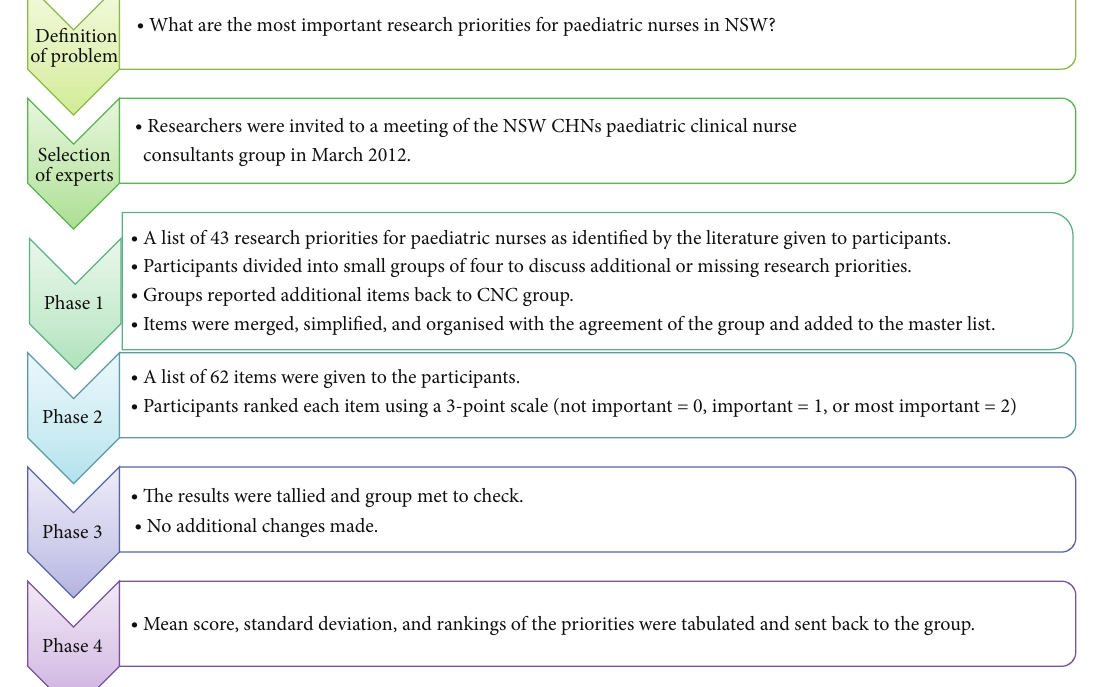
Figure 1: Nominal group technique process used in this